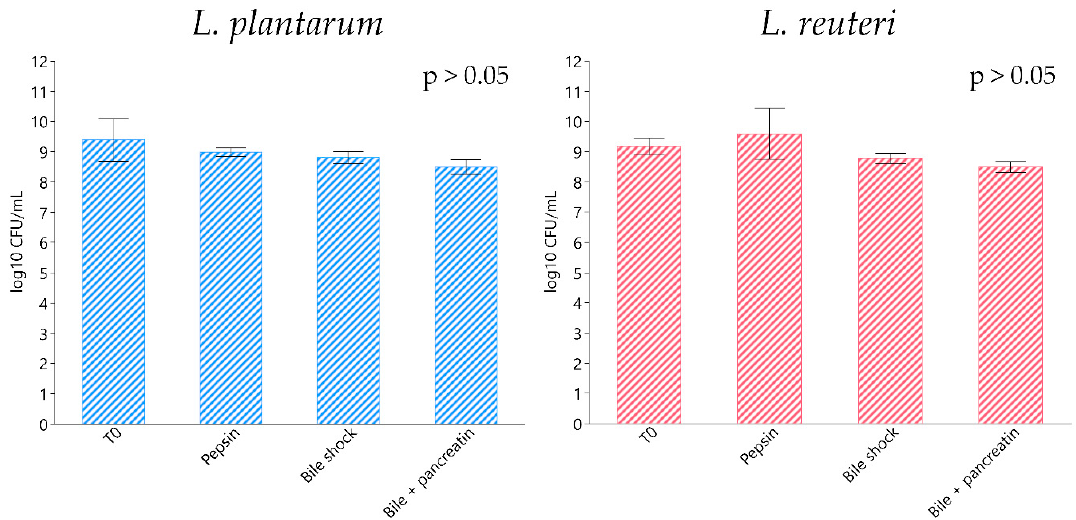
Figure 2. Simulated in vitro gastrointestinal digestion resistance of L. plantarum and L. reuteri. Data are expressed as least square means (LSMEANS) and standard errors (SE). T0 corresponds to the initial microbial charge measured before gastrointestinal environment simulation.